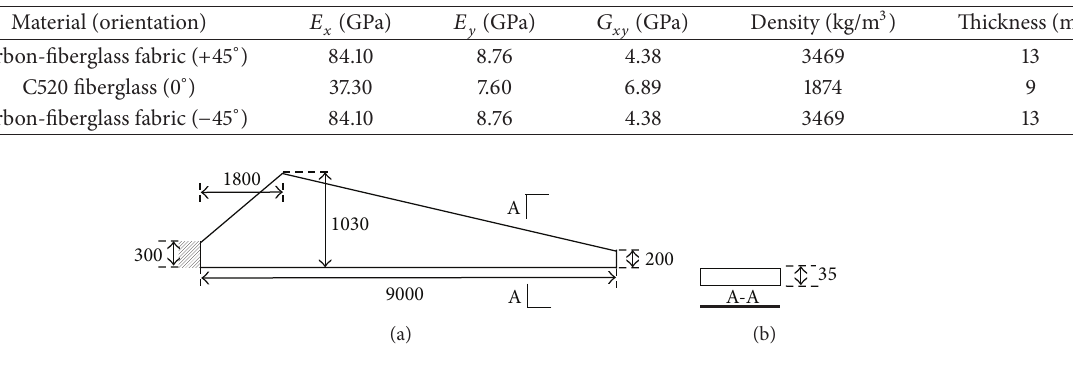
Figure 4: Wind turbine blade dimensions (mm) (a) top view and (b) cross section.